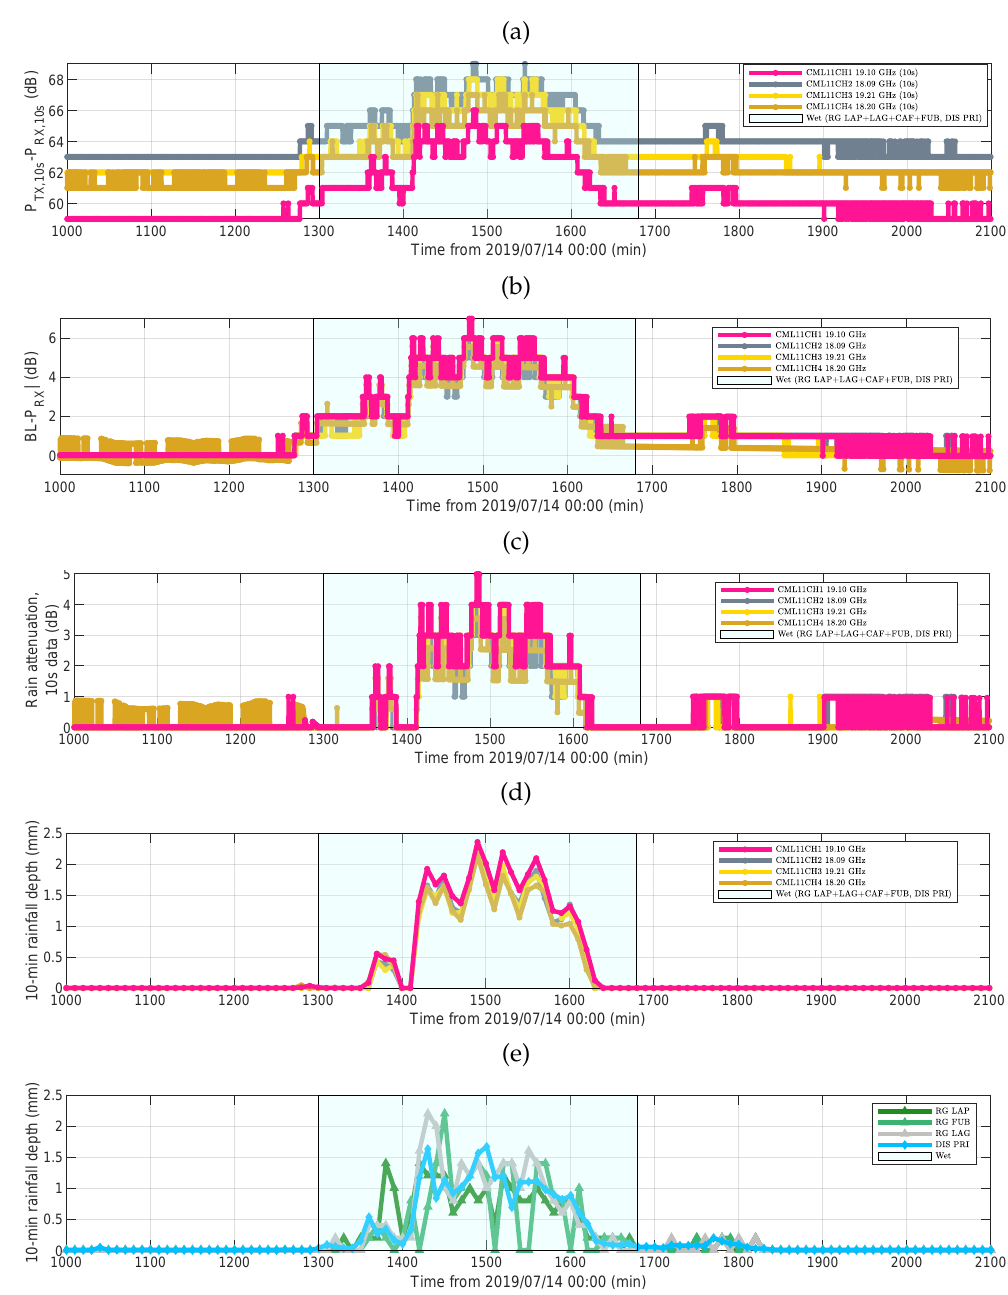
Figure 7. CML 11 and nearby rainfall sensors. ( a ) Difference between CML transmit and receive power levels (four channels), ( b ) total path attenuation assuming a zero-attenuation level with no rain, ( c ) rain attenuation, ( d ) 10 min rainfall depth, and ( e ) 10 min rainfall depth from nearby rainfall